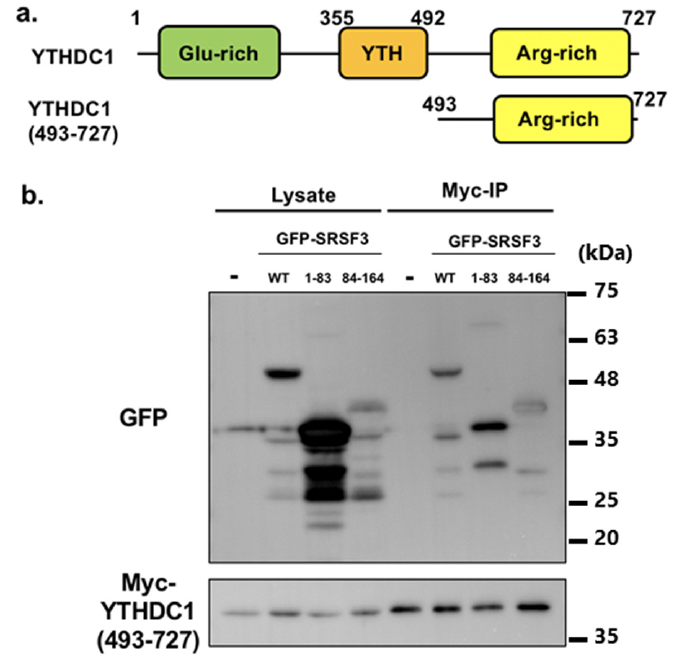
Figure 5. Interaction of YTHDC1 fragment with SRSF3. ( a ) YTHDC1 and its 493–727 fragment structure. ( b ) HeLa cells were co-transfected with GFP-SRSF3 wild type and mutants, and Myc- YTHDC1(493–727). The interaction between the C-terminal region of YTHDC1 with GFP-SRSF3 and its fragments was detected by western blotting using anti-GFP or anti-Myc antibodies. Some nonspecific bands are